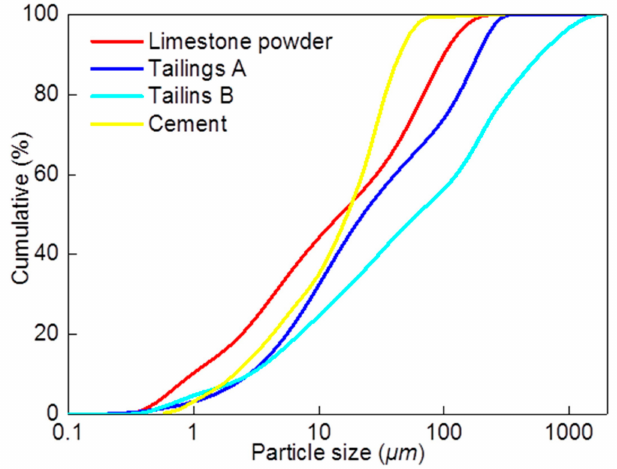
Figure 1. Particle size distribution of raw materials including limestone powder, tailing A, tailings B, and